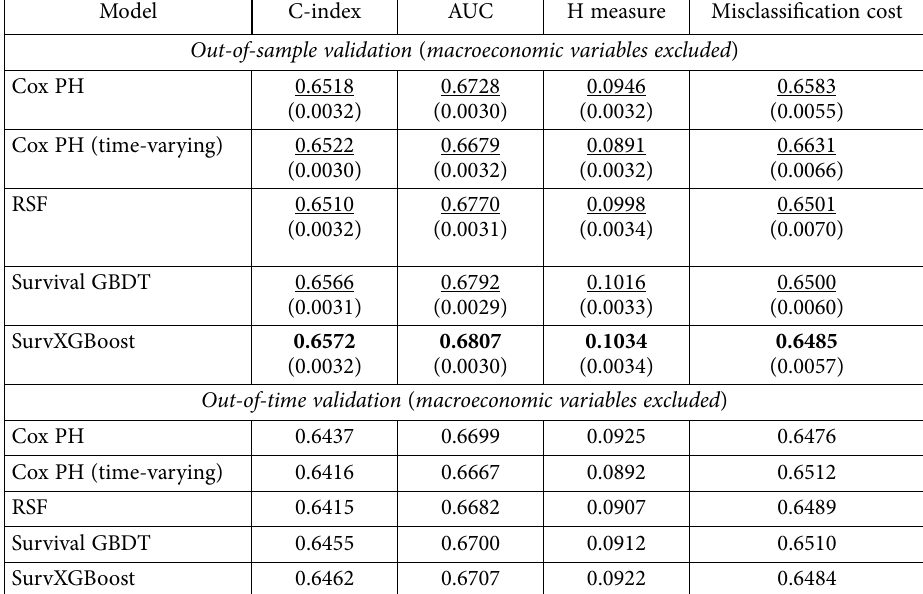
Table 7. Results of models under out-of-sample and out-of-time validation when macroeconomic vari- ables excluded